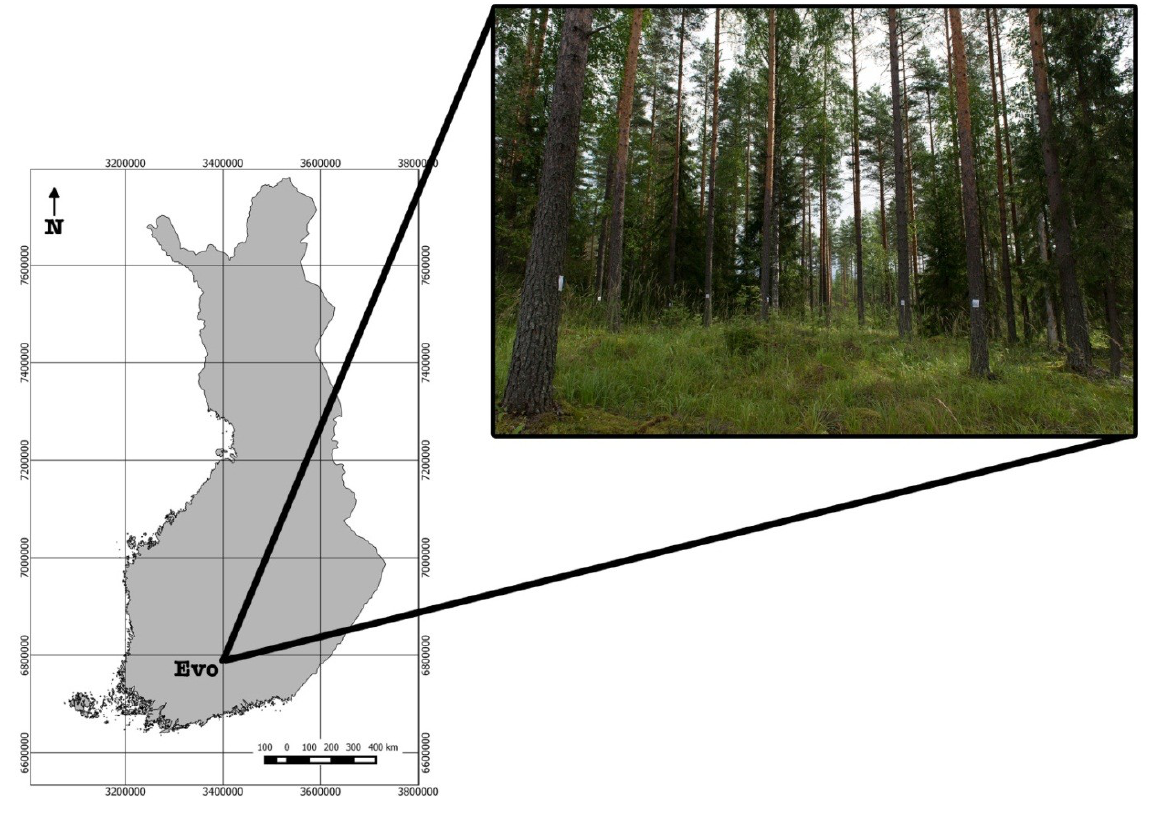
Figure 1. Study area and harvesting